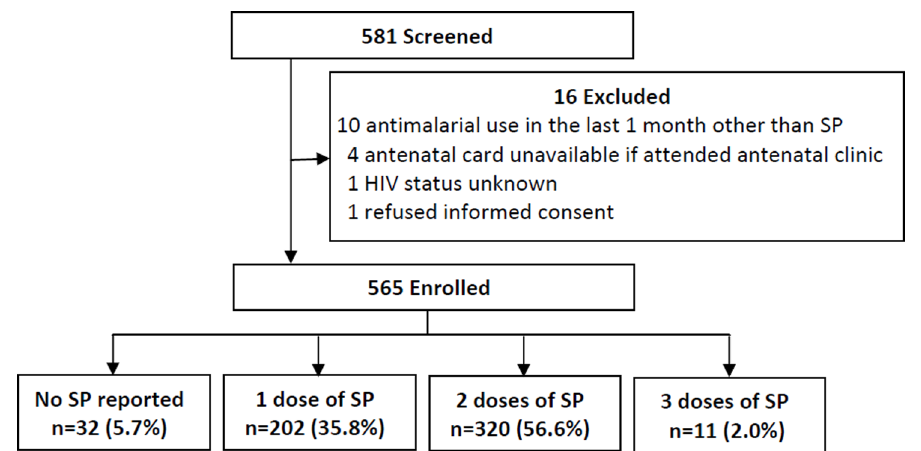
Figure 1. Study profile. SP=sulfadoxine-pyrimethamine.